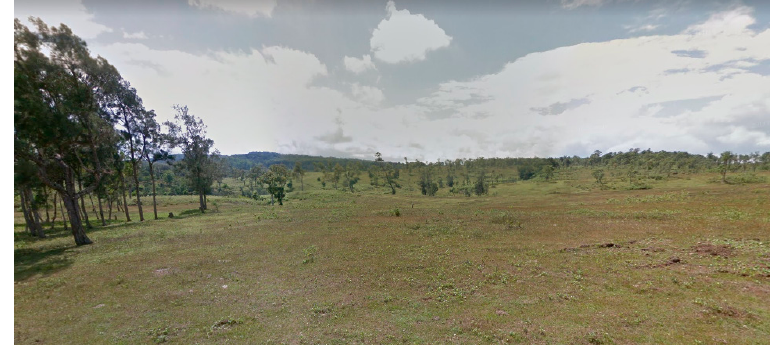
Figure 10. Typical arid savanna ecosystem in East Nusa Tenggara, Indonesia (9.84° S, and 124.25° E) (Courtesy: Google Street View).